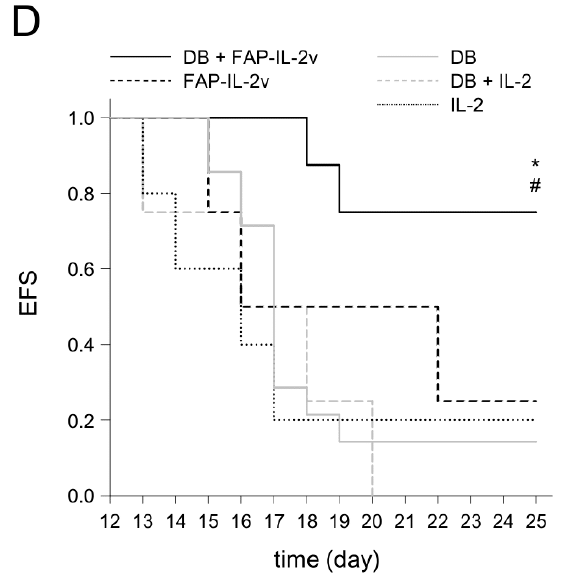
Figure 7. Establishment of a more resistant in vivo tumor model ( A ) and effects of the combinatorial immunotherapy with DB and FAP-IL-2v in vivo ( B – D ). ( A ) To establish a more resistant version of the murine syngeneic NB tumor model, DB treatment was started in a later tumor growth phase. After establishment of primary tumors, three later time points at which DB treatment was started (day 11 (open circles, dashed line), 12 (closed circles, solid line) and 14 (closed circles, dashed line)) were compared with day 4, representing the DB treatment starting time point of the previous NB model (open circles, solid line). Mice receiving equivalent doses of 0.9% NaCl served as controls (grey circles, solid line). When mice were sacrificed ahead of schedule due to tumor burden, the last measurement was included into the calculation of tumor growth at subsequent time points. Data are given as mean + SEM. ( B ) Schematic overview of the treatment protocol. The murine syngeneic GD 2 - expressing NB cells NXS2-HGW were injected on day 1, followed by establishment of primary tumors. When tumor size of 100 mm 3 was reached (indicated as day 12), treatment was started. Mice received either DB or FAP-IL-2v or a combination of both. To investigate IL-2-dependent effects, mice of two ad- ditional control groups were treated with IL-2 and DB in combination with IL-2. Tumor growth was de- termined daily. ( C ) Analysis of tumor growth in mice treated with DB in combination with FAP-IL-2v (DB + FAP-IL-2v, black solid line, closed circles), FAP-IL-2v (black solid line, closed squares), DB (black solid line, grey circles), DB in combination with IL-2 (DB+ IL-2, black solid line, grey squares) and IL-2 (black solid line, open circles). When mice were sacrificed ahead of schedule due to tumor burden, the last measurement was included into the calculation of tumor growth at subsequent time points. Data are given as mean + SEM. * p < 0.05 vs. DB + IL-2, t -test. ( D ) Analysis of event-free survival (EFS) probabilities in mice treated with DB in combination with FAP-IL-2v (DB + FAP-IL-2v, black solid line), FAP-IL-2v (black dashed line), DB (grey solid line), DB in combination with IL-2 (DB+ IL-2, grey dashed line) and IL-2 (black dotted line). A tumor volume of 300 mm 3 was defined as an event. Statistical analysis was performed using LogRank test; multiple comparison was done with Holm–Sidak method. * p < 0.05 vs. DB; # p < 0.05 vs. DB +